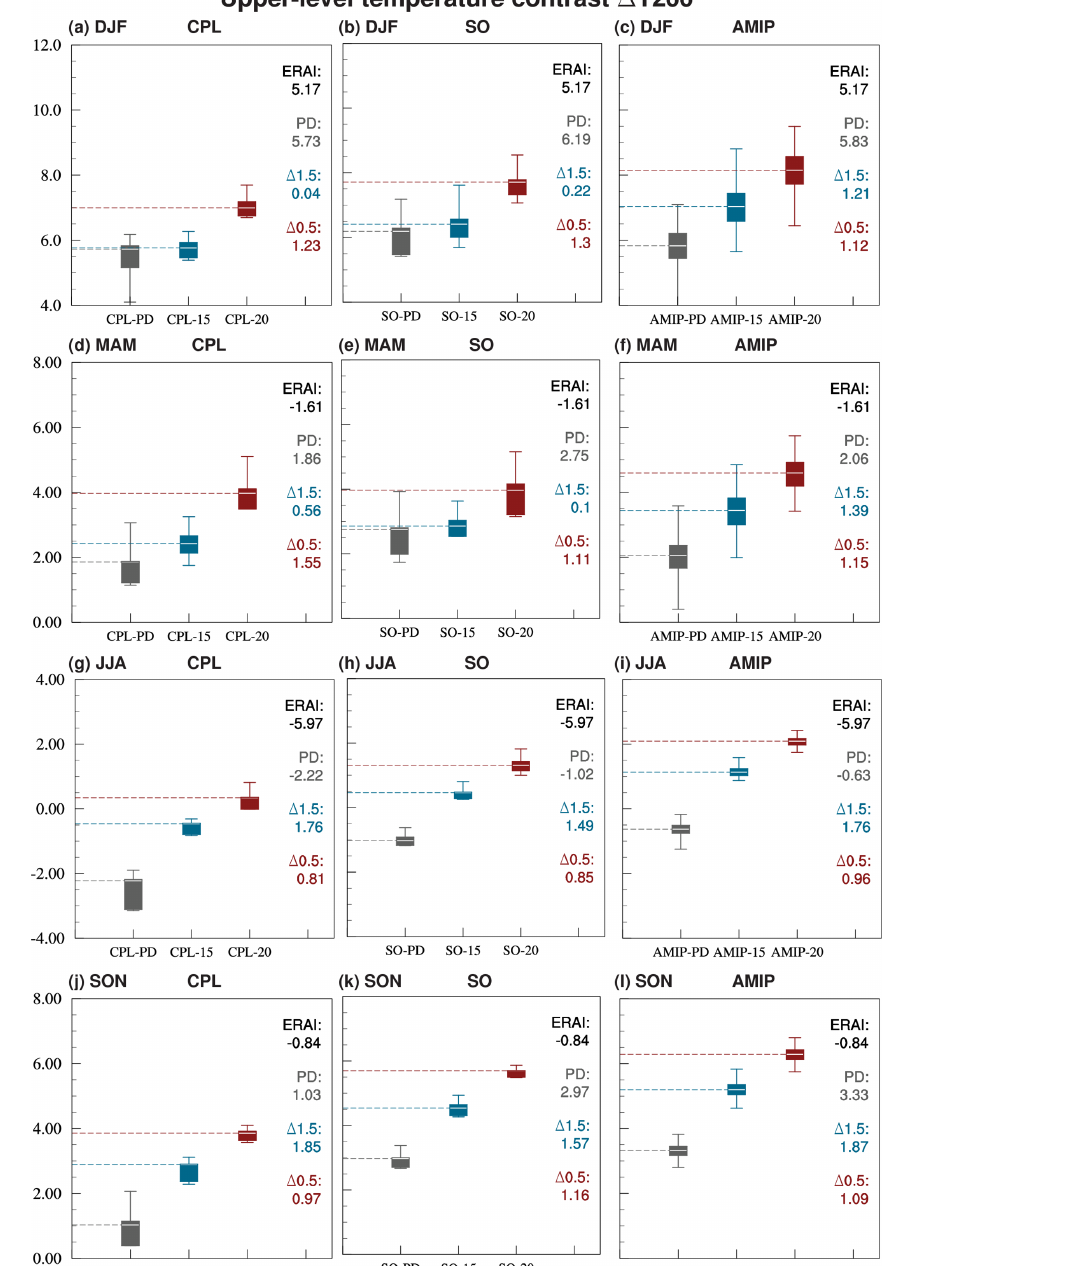
Figure 10. Upper tropospheric temperature contrast in the PD (grey), 1.5 ◦ C (blue), and 2.0 ◦ C (red) experiments from NorESM1-Happi (a, d, g, j) , NorESM1-HappiSO (b, e, h, k) , and NorESM1-HappiAMIP (e, f, i, l) for DJF (a–c) , MAM (d–f) , JJA (g–i) , and SON (j–l) . The upper-level temperature contrast ( (cid:49)T 200 ) is defined as the 200hPa temperature difference between an area over the tropics (30 ◦ S–30 ◦ N) and an area over the Arctic (poleward of 60 ◦ N). The white lines within the boxes indicate the median values, the boxes indicate the interquartile range, and the whiskers the full spread of the different decades in each experiment (nine in NorESM1-Happi, nine in NorESM1-HappiSO, and 125 in NorESM1-HappiAMIP). The dashed horizontal lines emphasize the median values; numbers are shown on the right side of each panel for ERA-Interim (top black), PD (second from top, grey), the change with 1.5 ◦ C warming relative to PD (third from top, blue), and the change with the additional 0.5 ◦ C warming (bottom, red). The ERA-Interim values are computed using the years 1986–2015. The NorESM data are for the default periods given in Sect. 3. Units are in degrees Celsius (a–l) .